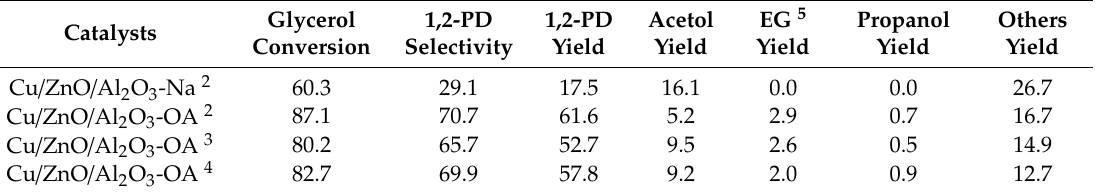
Cu / ZnO / Al 2 O 3 -OA 4